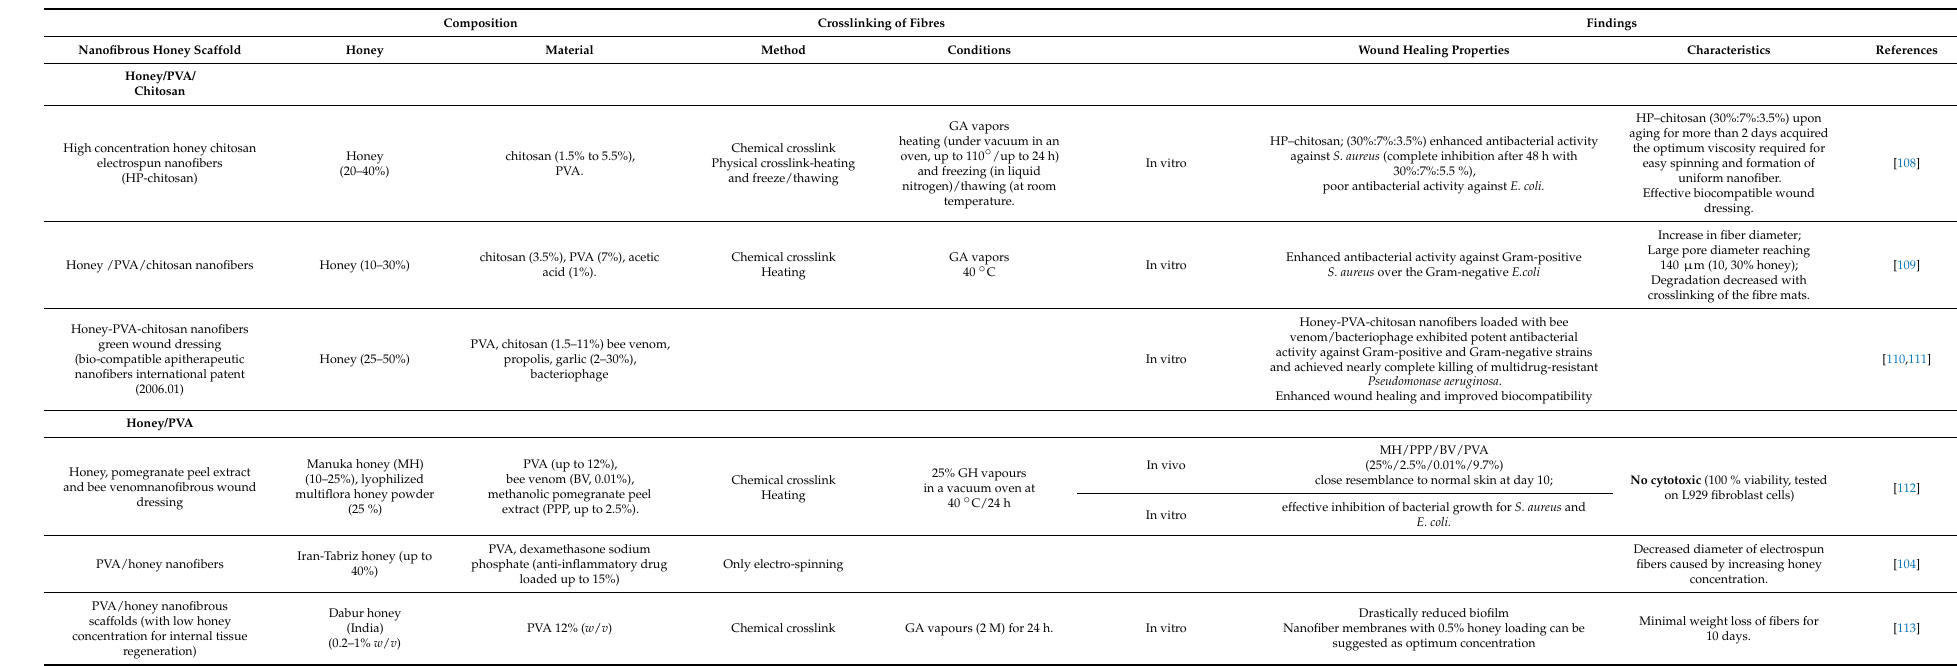
Table 3. Examples of honey electrospun nanofibrous scaffolds, obtention methods and main